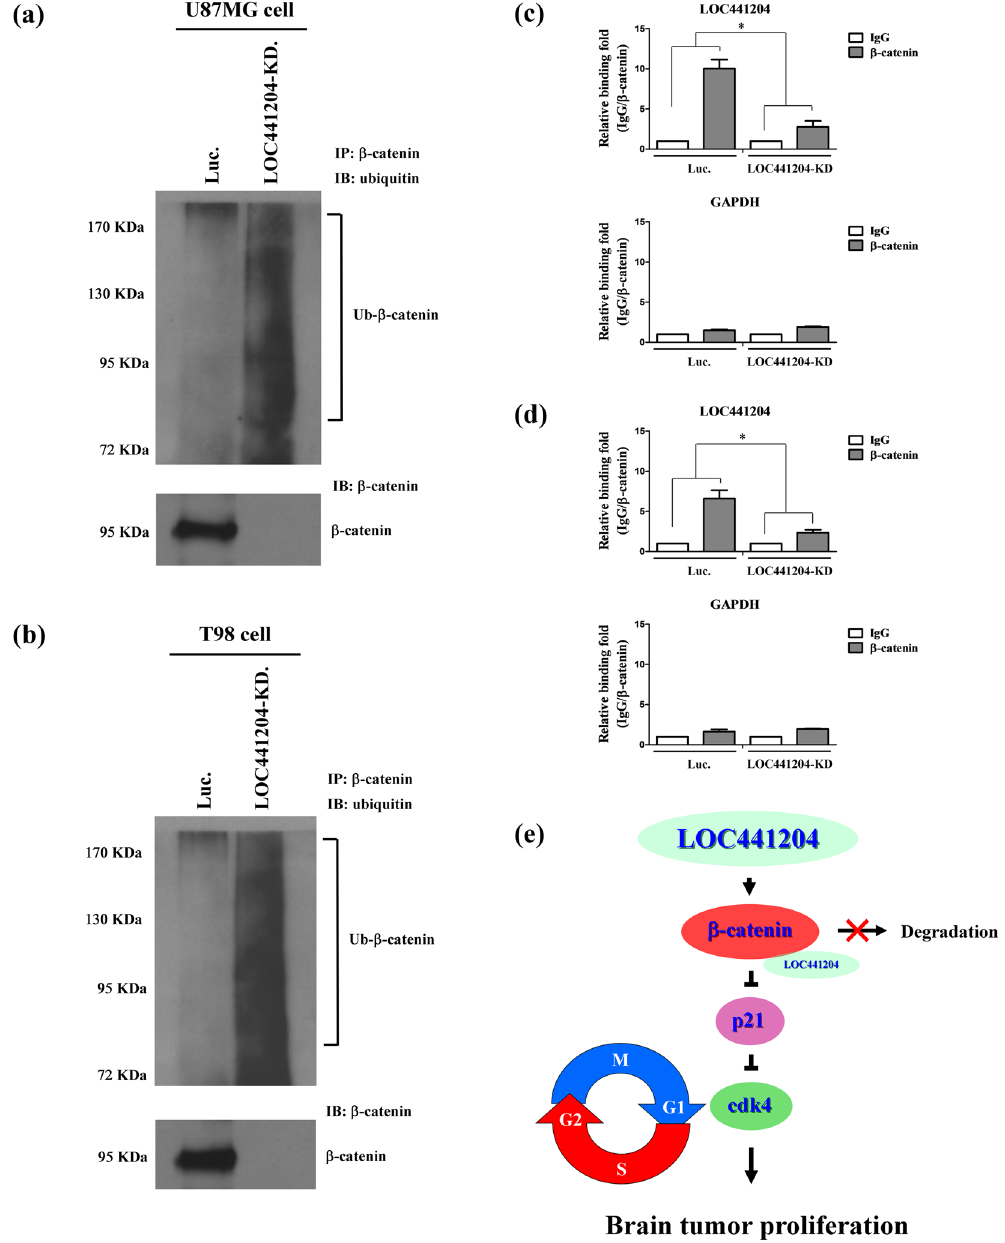
Figure 5. β -catenin degraded by ubiquitylation in LOC441204 depleted cells. The immunoprecipitation assays of ( a ) U87MG and ( b ) T98 cell lines were analyzed under LOC441204-depleted (LOC441204-KD.) and control (Luc.) conditions. Ubiquitinated β -catenin was analyzed by Western blot. The RIP assays were performed in ( c ) U87MG and ( d ) T98 cell lines under similar conditions. GAPDH is a negative binding control. ( e ) Schematic diagram of LOC441204-mediated enhancing of brain tumor proliferation through the β -catenin/p21/cdk4 cascade. Differences were analyzed using the Kruskal–Wallis test ( * P <